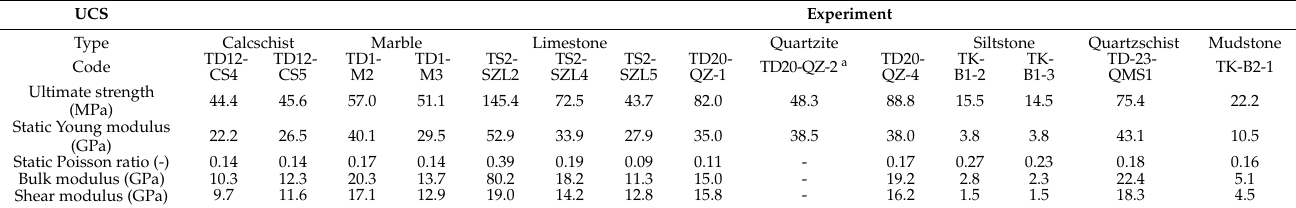
Table 8. Static elastic parameters obtained from the UCS experiments.